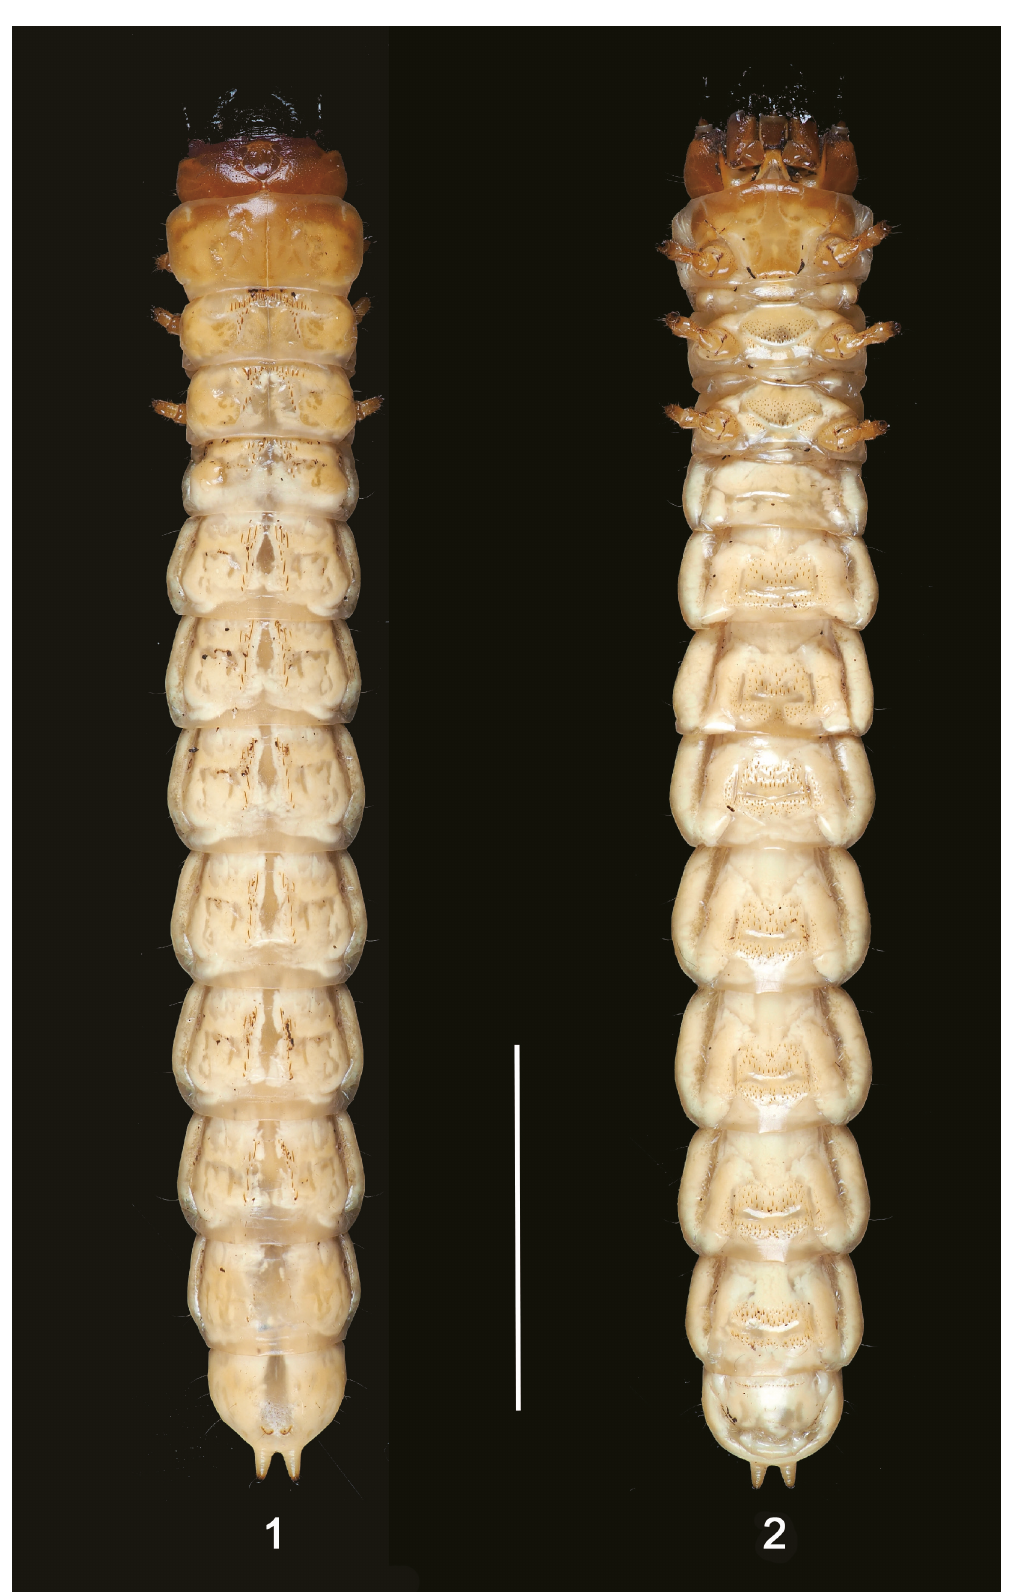
Figs 1–2. Habitus of last-instar larva of Trictenotoma formosana Kriesche, 1919. 1 . Dorsal view. 2 . Ventral view. Scale bar: 20